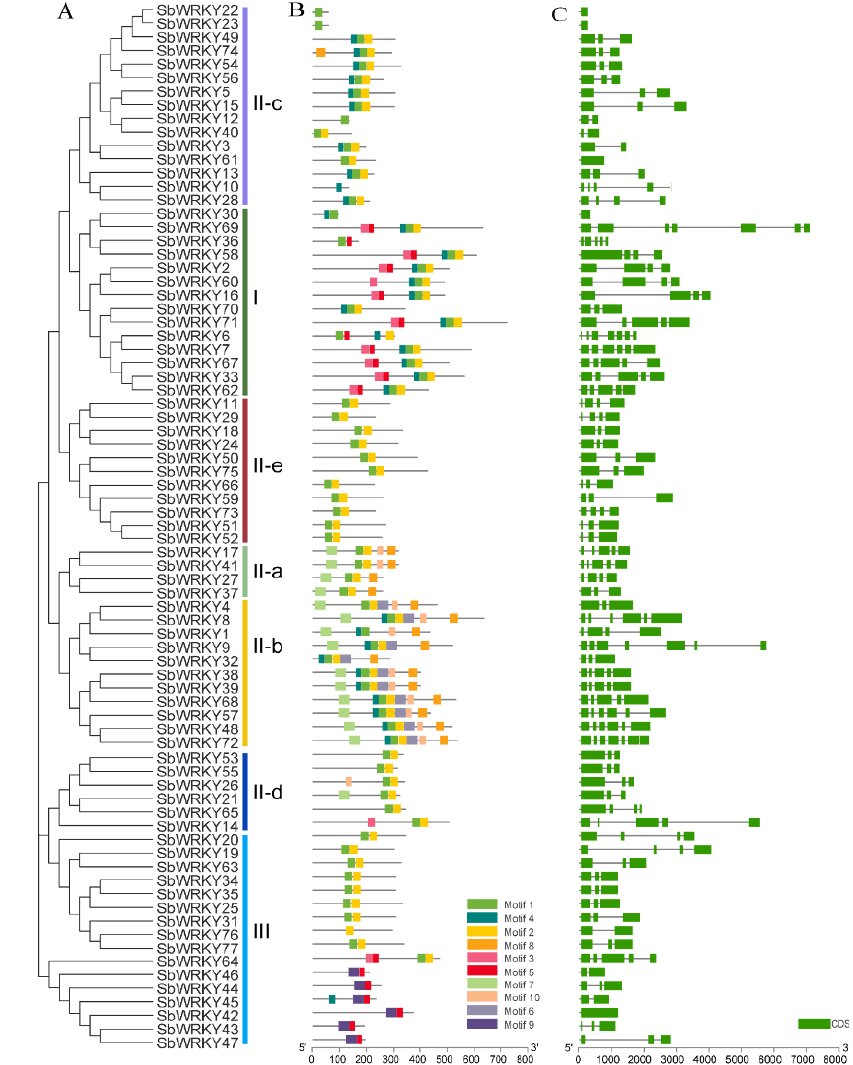
Figure 4. The phylogenetic relationships, gene structure, and composition of conserved motifs in WRKY from S. baicalensis. ( A ) The phylogenetic on the left contains 77 WRKY proteins (named SbWRKY1 to SbWRKY77). ( B ) The motif patterns of 77SbWRKY proteins. ( C ) Exon/intron structures of WRKY genes.